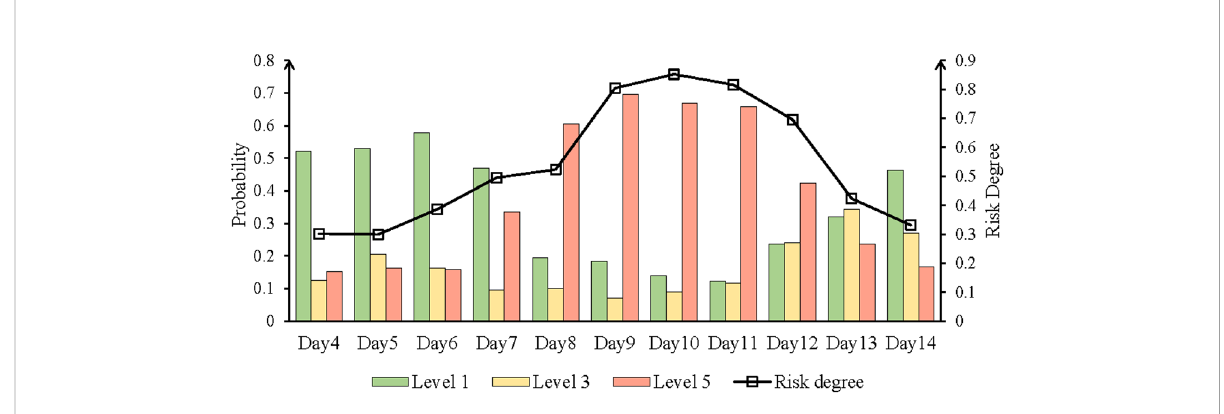
FIGURE 8 Comparison of evaluation results obtained by FCE and